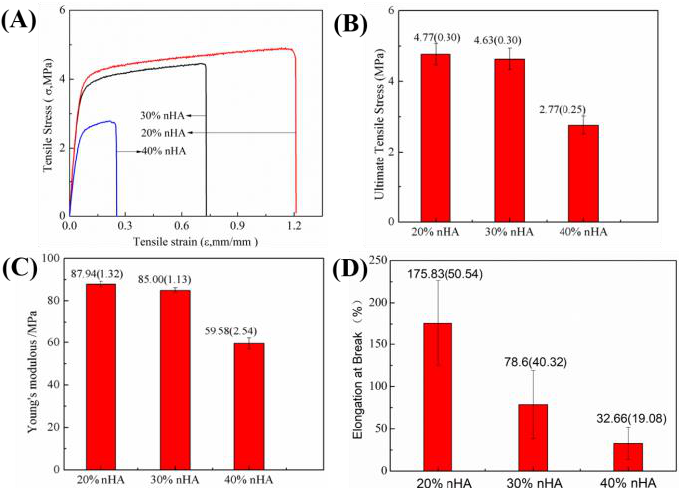
Figure 5. Mechanical properties assessment of nHA-PBP hybrid membranes with different nHA contents. ( A ) Stress – strain behavior; ( B ) Ultimate tensile strength; ( C ) Young’s modulus; ( D ) Elongation at break.